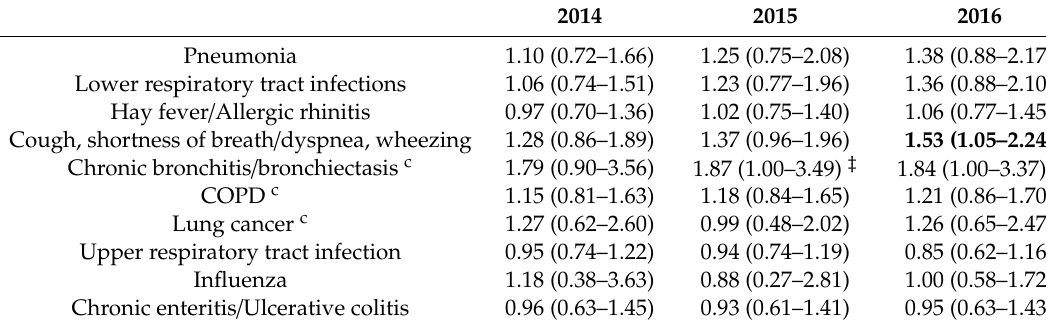
Table A12. Di ff erences (OR, 99% CI) a per year between livestock dense areas and control areas among asthma patients b (statistically significant results in bold)